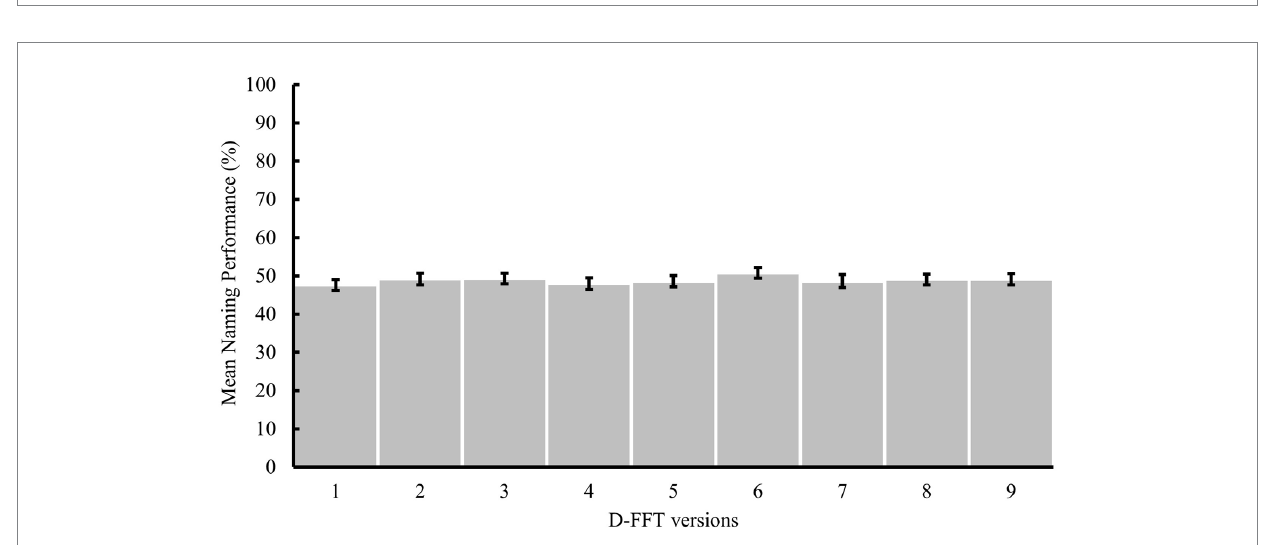
FIGURE 8 Mean naming performance on the nine D-FFT versions in step 5 with error bars representing the standard errors of the means.